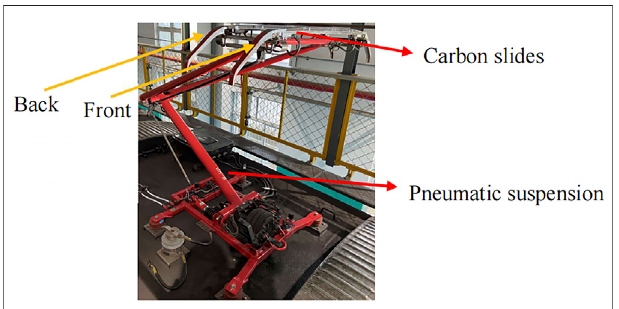
FIGURE 1 | Picture of the pantograph.